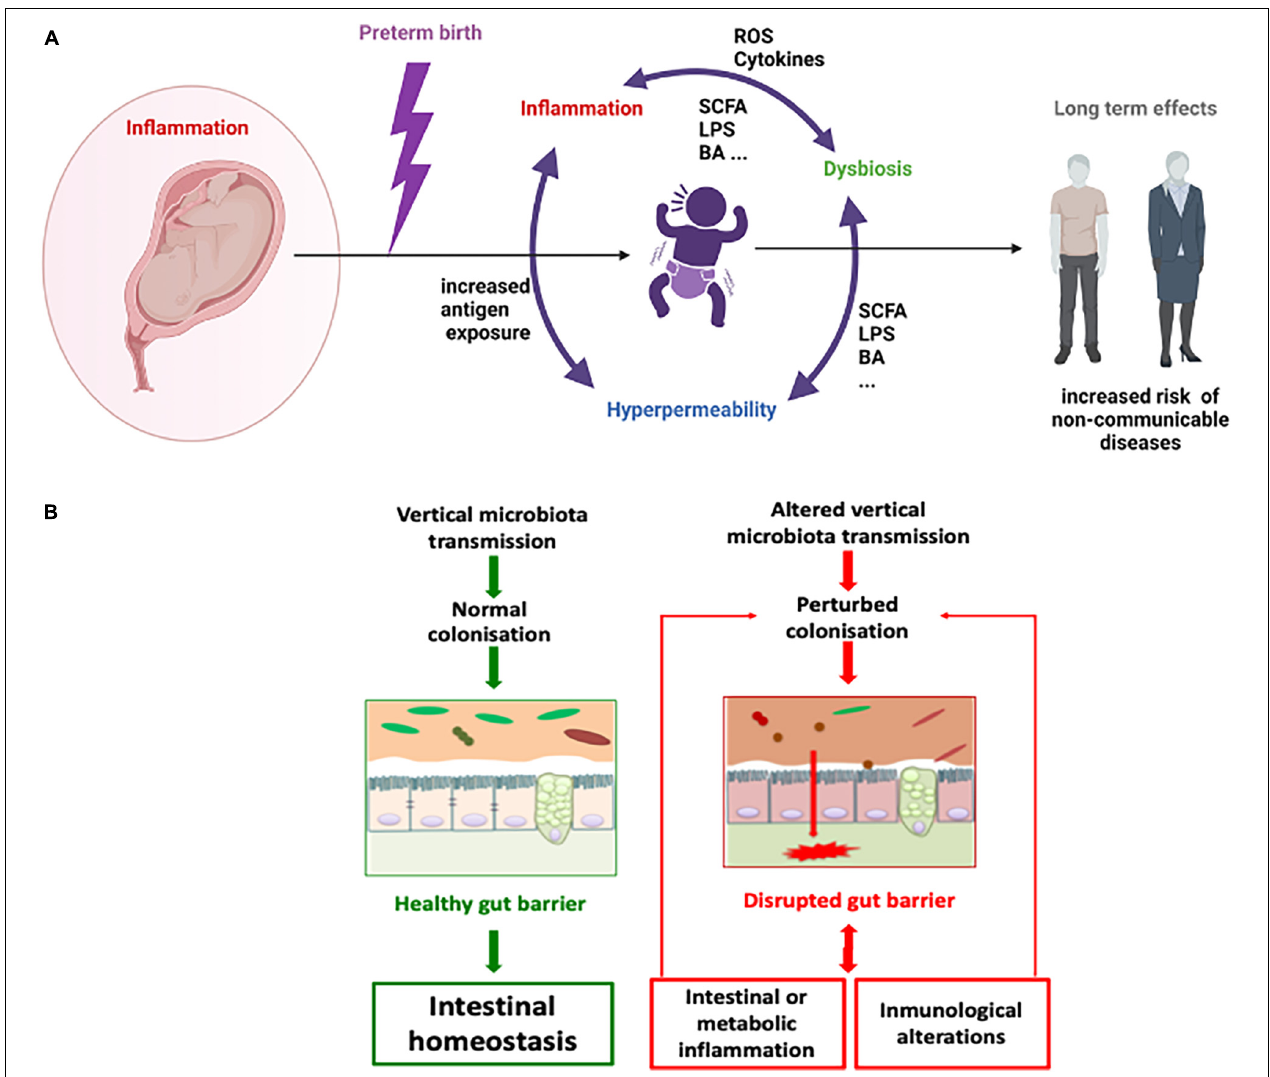
FIGURE 1 | Microbial dysbiosis, inflammation and hyperpermeability vicious circle in the preterm context. A general schema (A) and a focus on gut barrier (B) . SCFA = short chain fatty acids, BA = bile acids, ROS = reactive oxygen species, LPS =